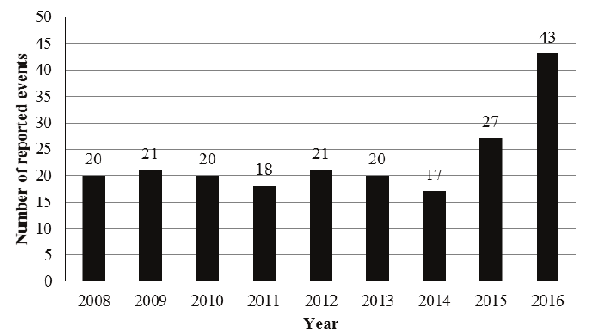
Fig. 4. Number of events caused by piston engines installed on Polish registered aircraft between 2008-2016